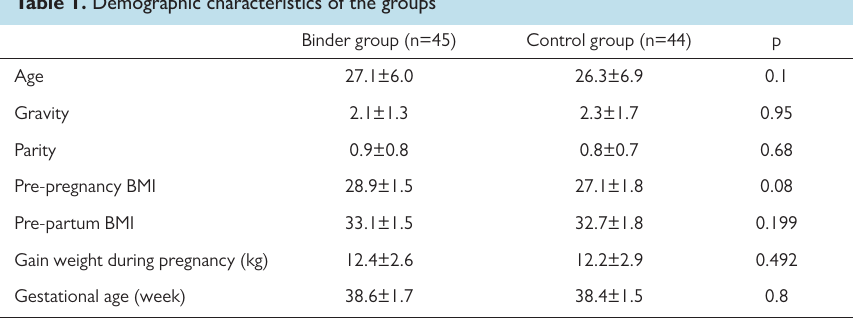
Figure 1. Flow diagram of the groups. 6MWT: 6-minute walk test; ABG: abdominal binder group; n-ABG: no binder group Table 1. Demographic characteristics of the